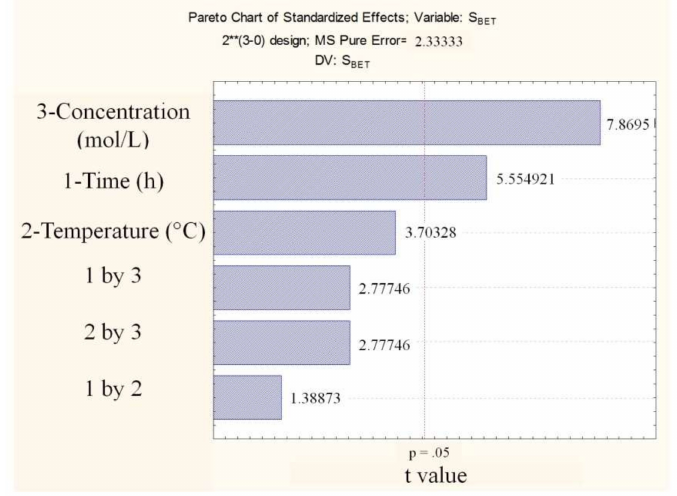
Figure 6. Statistical analysis. Effect of the parameters on the specific surface area